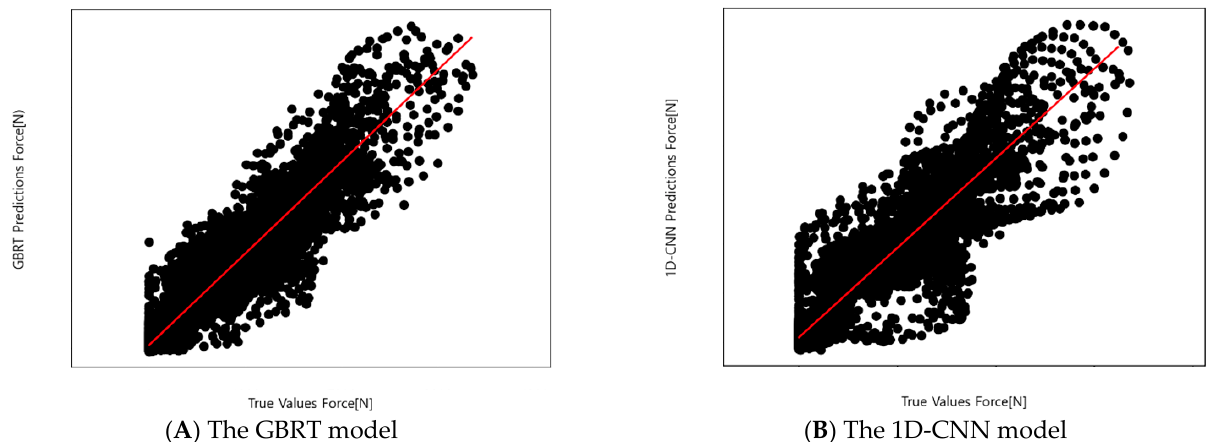
Figure 15. Chart comparing the actual and predicted values of the GBRT and 1D-CNN models based on base specification data.